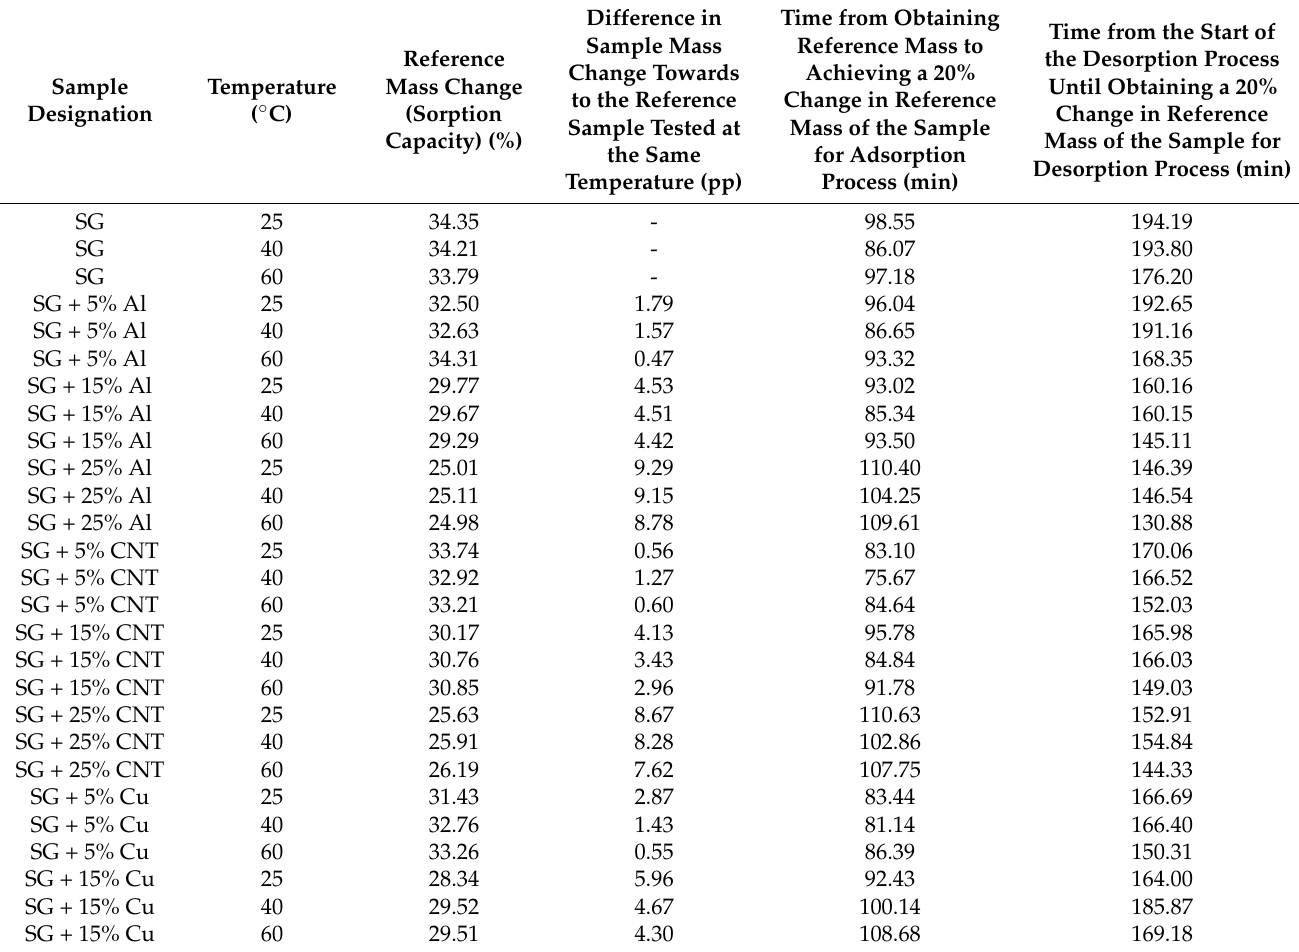
Table 2. Percentage change in reference mass of all tested